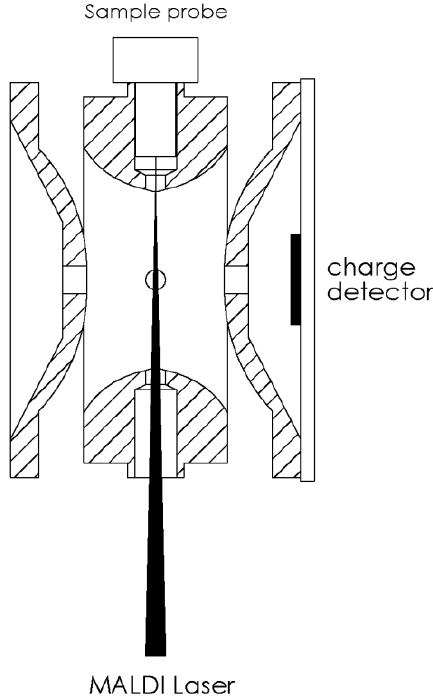
Figure 8. Experimental setup of our homemade MALDI frequency-scanned quadrupole ion trap mass spectrometer with a charge detector.